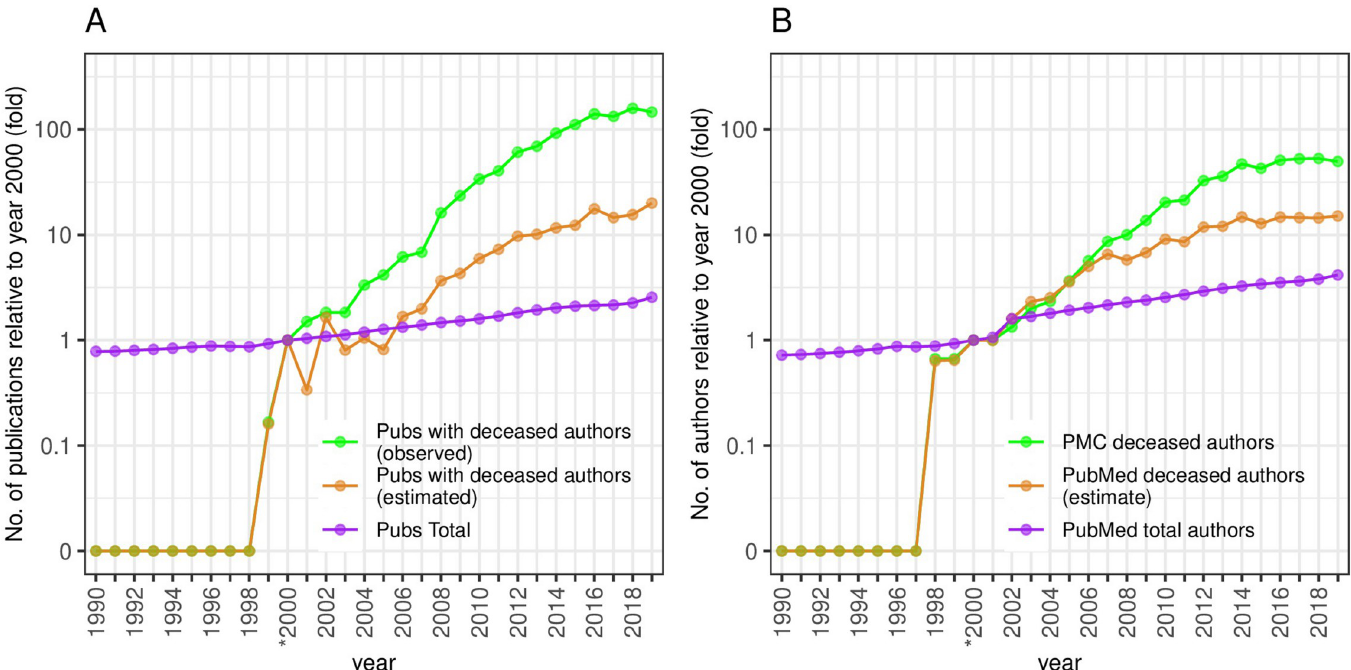
Fig 1. Rapid growth of publications with deceased authors in the PubMed database. (A) The fold increase of the relative increase of publications containing a deceased author (green) and the relative growth of total publications (purple) and the adjusted estimated deceased-author publications (orange) in PubMed. The baseline for deceased author and total publications was set at year 2000 ( � ). (B) Rapid growth of deceased authors in the EPMC database. The growth of deceased authors in the biomedical literature (green), the growth of the pool of total unique authors in PubMed (purple) and the estimated number of deceased authors in PubMed (orange). The baseline for deceased and total authors was set at year 2000 ( �